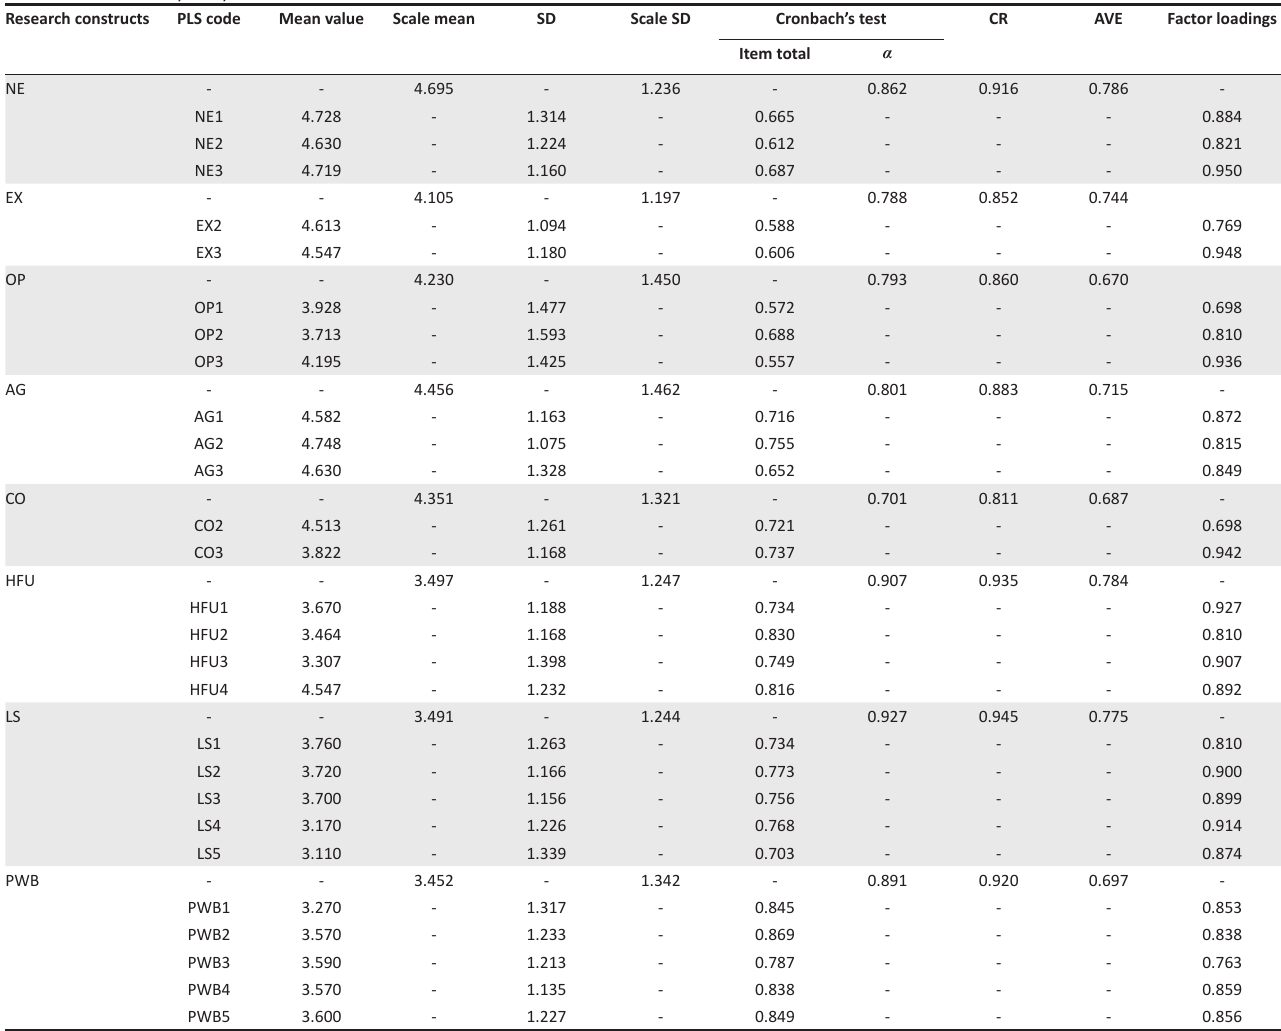
TABLE 3: Scale accuracy